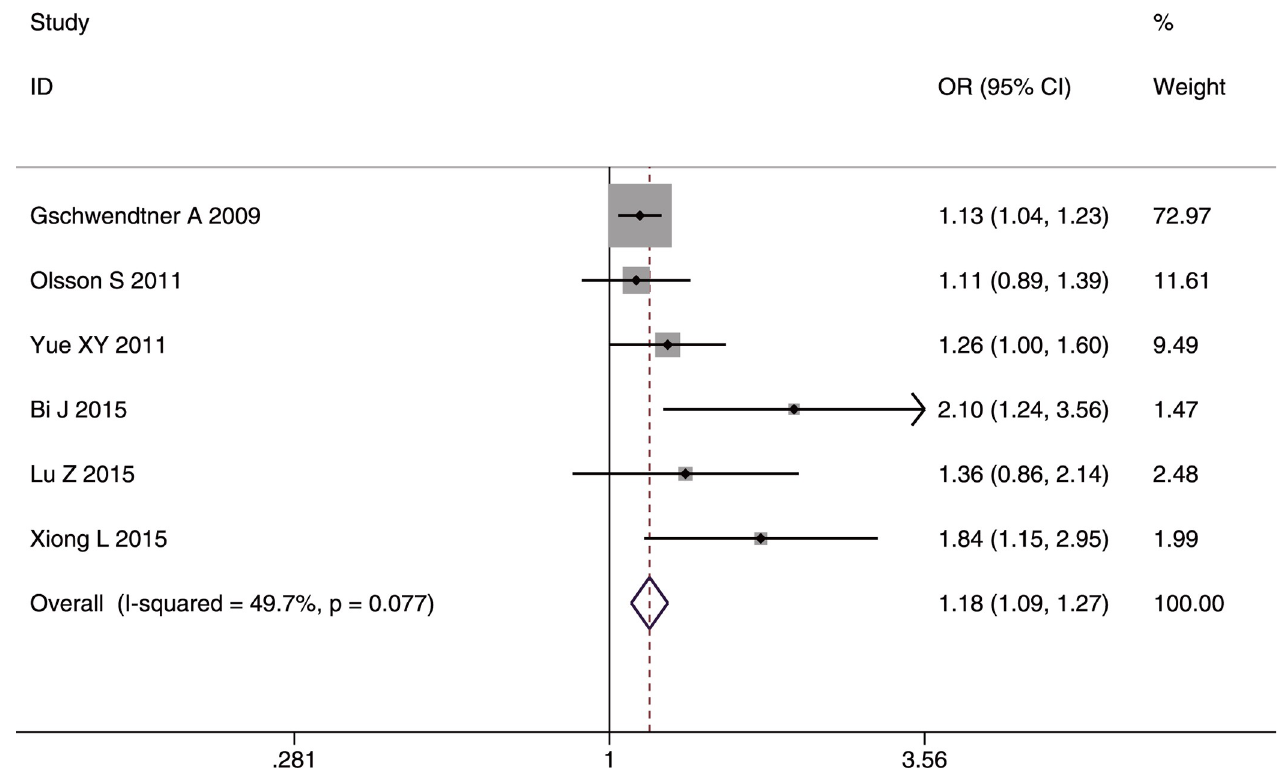
Fig 10. Forest plot of rs1537378 genotype frequency (CC vs. (CT+TT)) and susceptibility to all types of IS in the whole studied population.